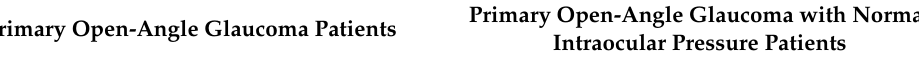
Table 6. Distribution of Bebie curve from the visual field examination for POAG and NTG patients at the first